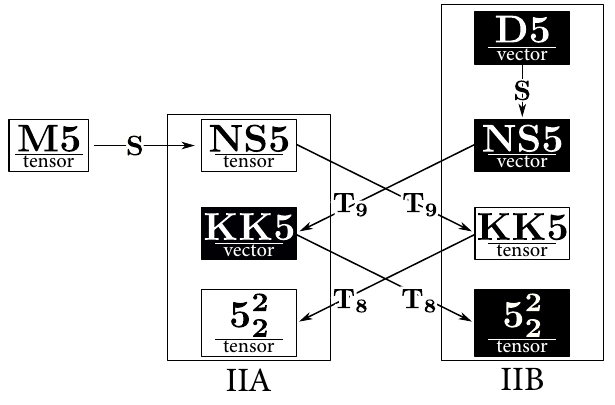
Figure 1 . Type II five-branes related by S- and